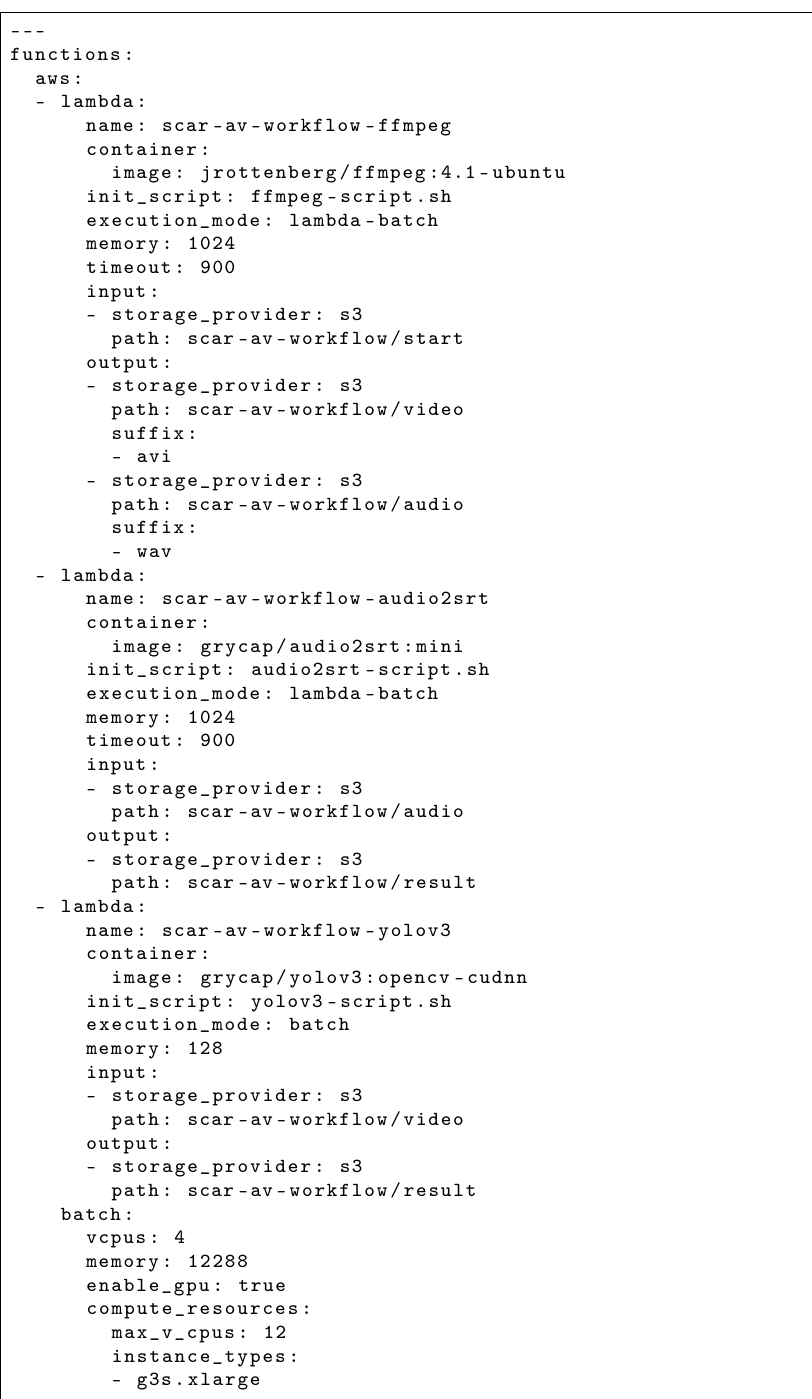
Figure 2. Functions Definition Language